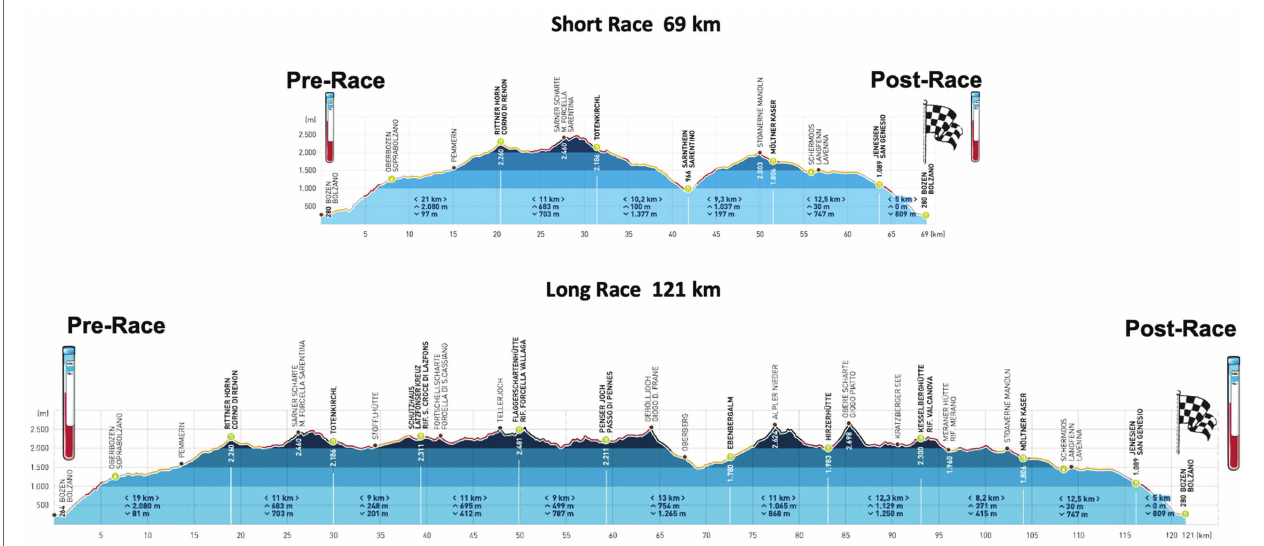
FIGURE 1 | Race profile of the Südtirol Ultra Sky-Race: in the upper part of the figure “the short race” and below “the long race” competition is shown. At pre and post, blood sampling was performed